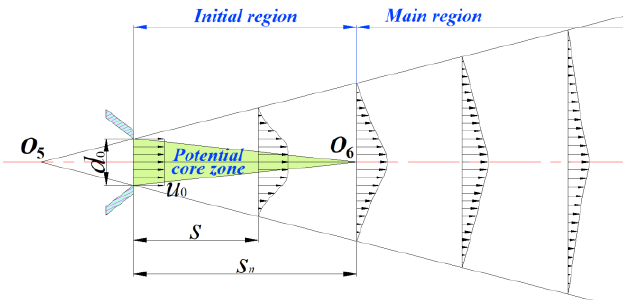
Figure 10. Structure diagram of gas submerged jet. Note: O 5 , intersection of the outer boundary of the jet; O 6 , the end of the potential core zone; d 0 is the air-nozzle outlet ’s diameter, mm; u 0 , initial velocity, m·s; s , distance between the intersection of the air nozzle ’s axis and the seeding plate and the center of the air nozzle ’s outlet, mm; and s n , length of the potential core zone, mm. In engineering calculations, the turbulence coefficient for axisymmetric convergent nozzle is generally taken as a = 0.066 ‒ 0.071 [30]. In this paper, the turbulence coefficient of a = 0.07 is selected and substituted into Equation (11) together, with d 0 = 5 mm, and the distance between the intersection of the air nozzle ’s axis and the seeding plate and the center of the air nozzle ’s outlet is obtained as s < 24 mm. In order to make the airflow drag force on the cotton seeds larger, the distance, s , should be as small as possible under the condition that the space position does not interfere with other components. In this study, the center position of the air nozzle’s outlet was selected on the circle of a seeding plate with a radius of R 4 = 88 mm. At this time, the distance between the intersection of the air nozzle’s axis and the seeding plate and the center of the air nozzle’s outlet was calculated as s = 14.08 mm, which meets the normal operation of the seed-disturbing air nozzle.